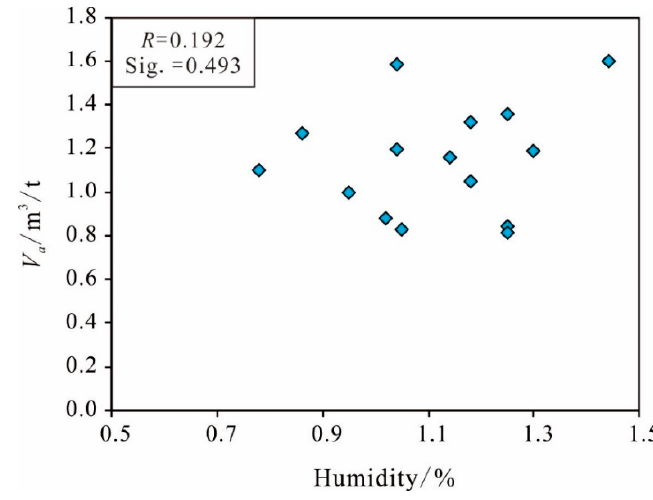
Figure 23. No obvious relationship between V a and humidity.